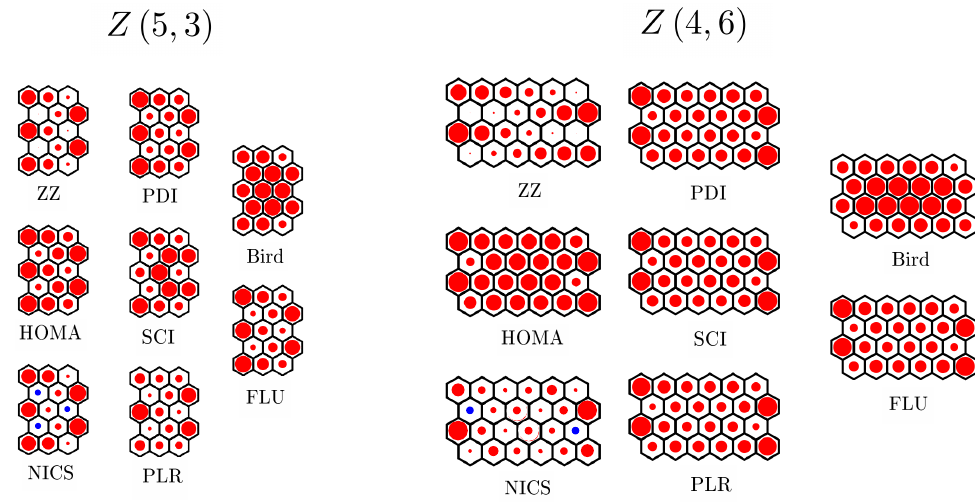
Figure 6. ZZ aromaticity indices computed for all the hexagons of multiple zigzag chains Z ( 5,3 ) ( left ) and Z ( 4,6 ) ( right ) are compared to analogous quantities obtained from rigorous quantum chemical calculations. We use the following quantum chemical aromaticity indicators: NICS [81], HOMA [82,83], Bird [84], PDI [85], SCI [86], PLR [87–90], and FLU [91]; for more details, see in [92]. The size of the red circle corresponds to the aromaticity of each hexagon, with the largest circle corresponding to the maximal aromaticity obtained with each method. The blue circles in NICS aromaticity patterns correspond to anti-aromatic hexagons with positive chemical